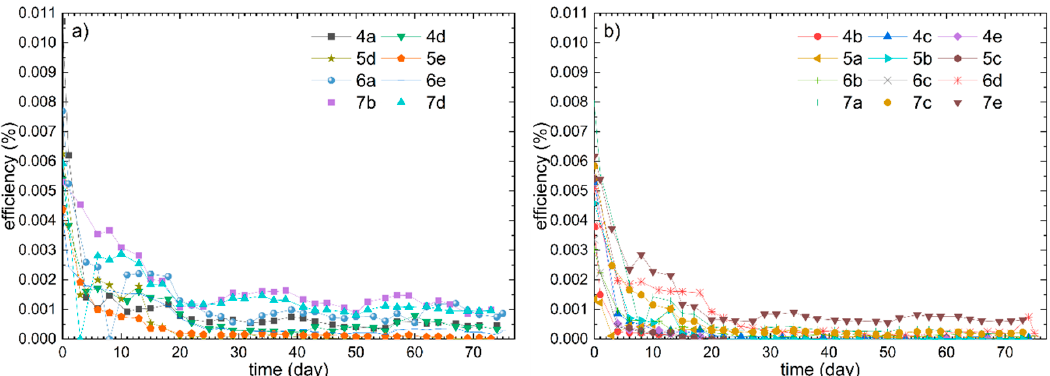
Figure 3. Efficiency curves of the two best DSSCs of samples 4 to 7, all with different MWs of PEO, are shown in ( a ) and the progressions of the further DSSCs of those samples are shown in ( b ). The following MWs were applied: 40 kg/mol in sample 4, 100 kg/mol in 5, 300 kg/mol in 6 and 1000 kg/mol in 7.